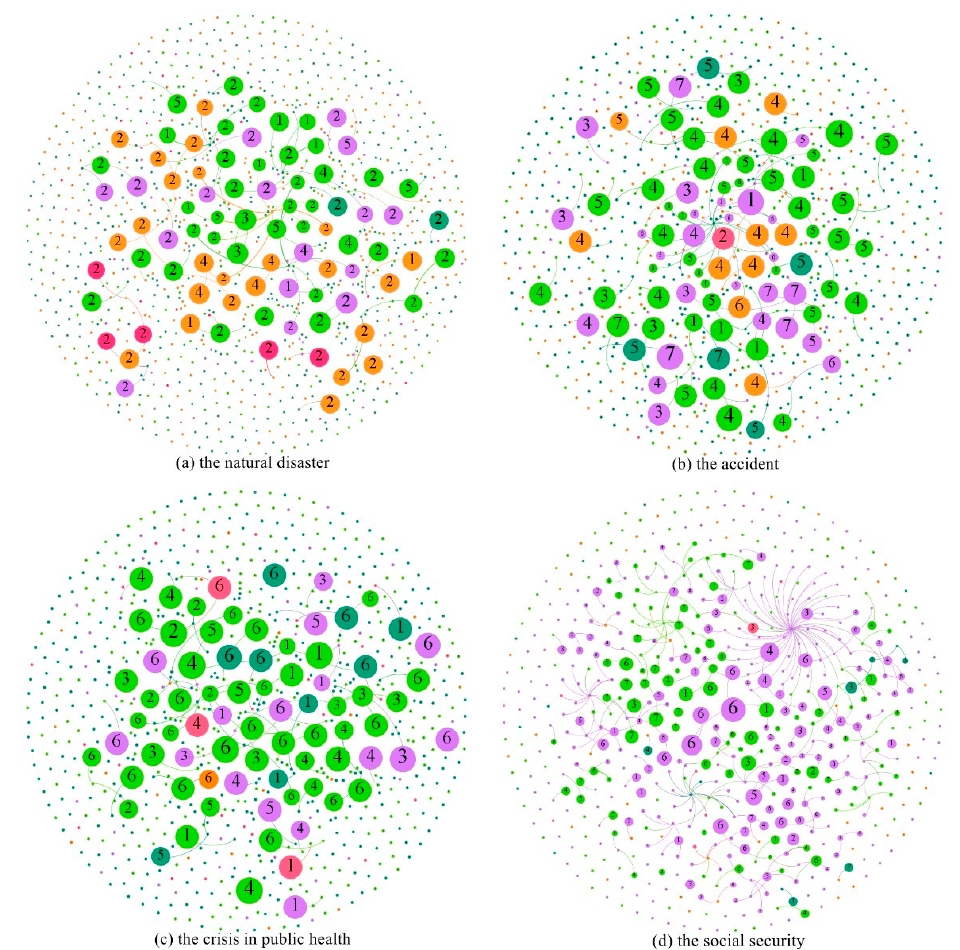
Figure 4. Topic propagation maps of four events. In the figure, ordinary users are represented in purple, celebrities in light green, the government in orange, institutions and enterprises in light red, and media in dark green.